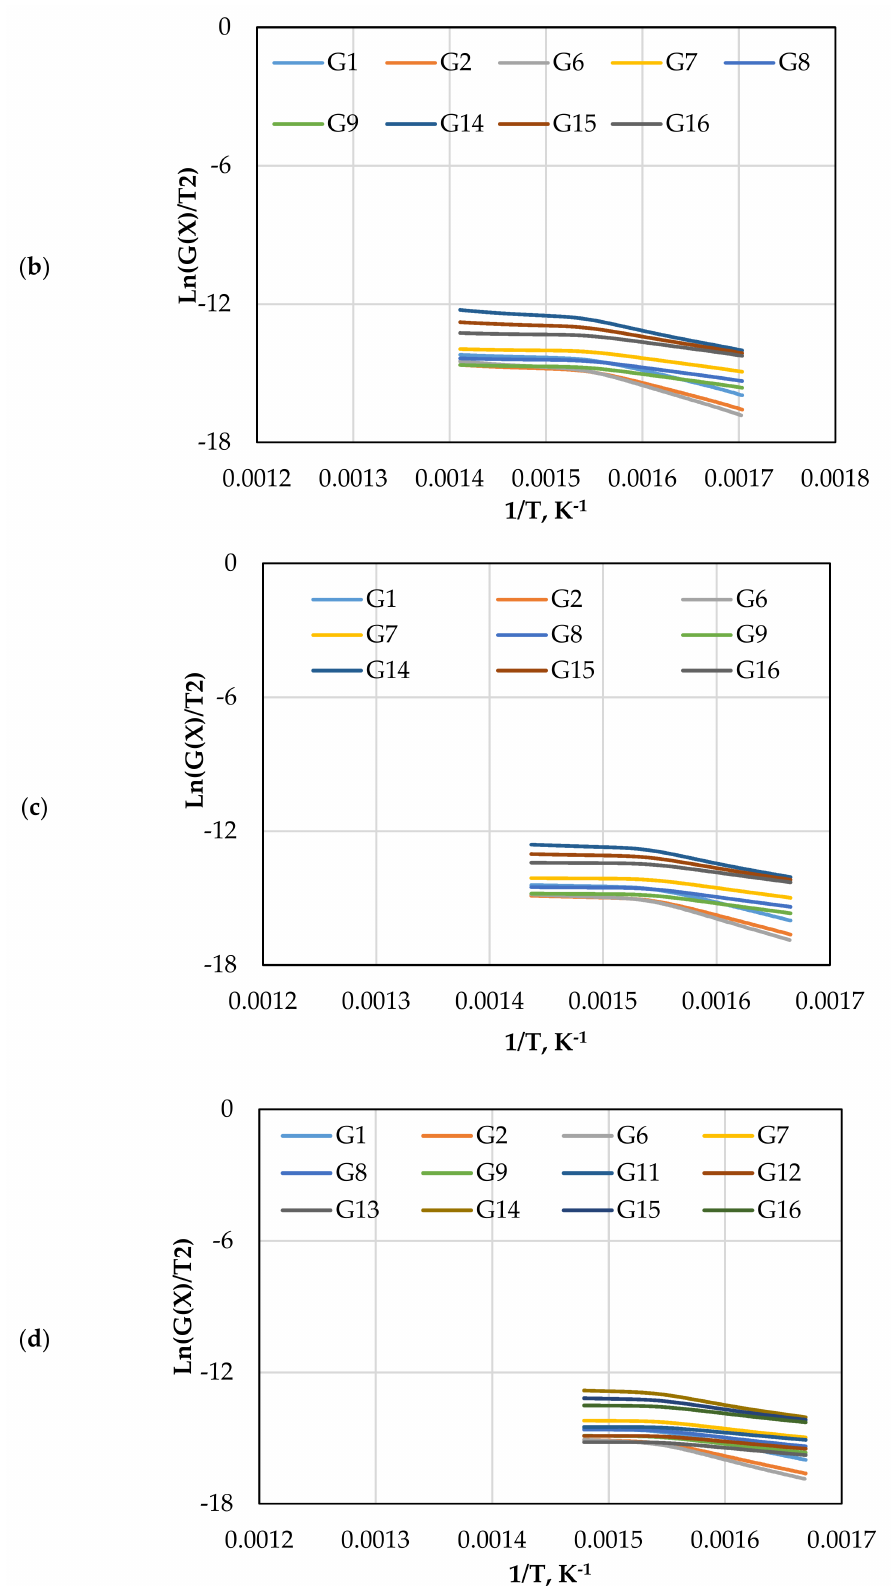
Figure 5. The CR method plots for CO 2 gasification at different dolomite loadings: ( a ) 0 wt.%, ( b ) 5 wt.%, ( c ) 10 wt.%, and ( d ) 15